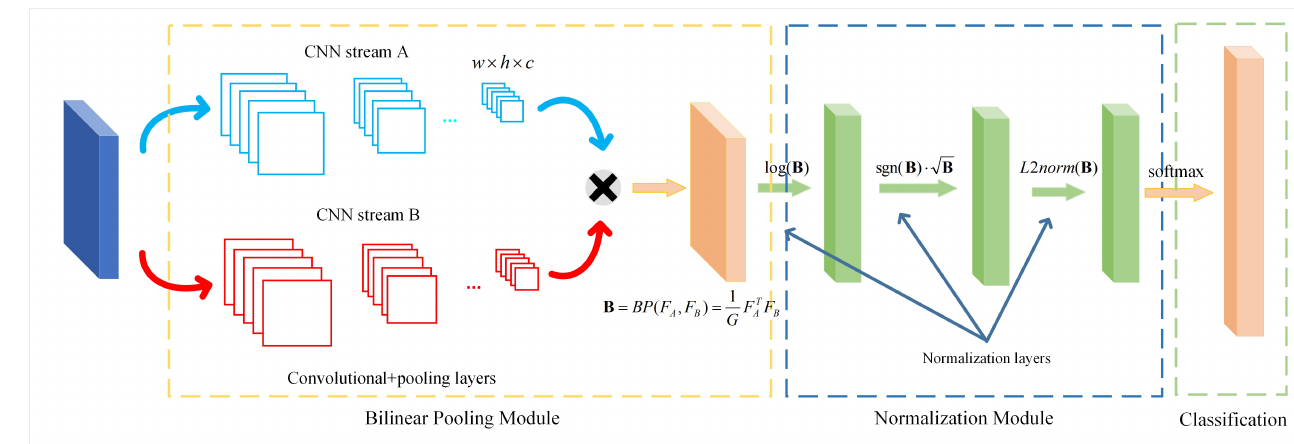
Figure 2. BCNN architecture. The images firstly go through CNNA and CNNB, and use the matrix outer product of each image’s output, whose result then goes through the layers of normalization and classification